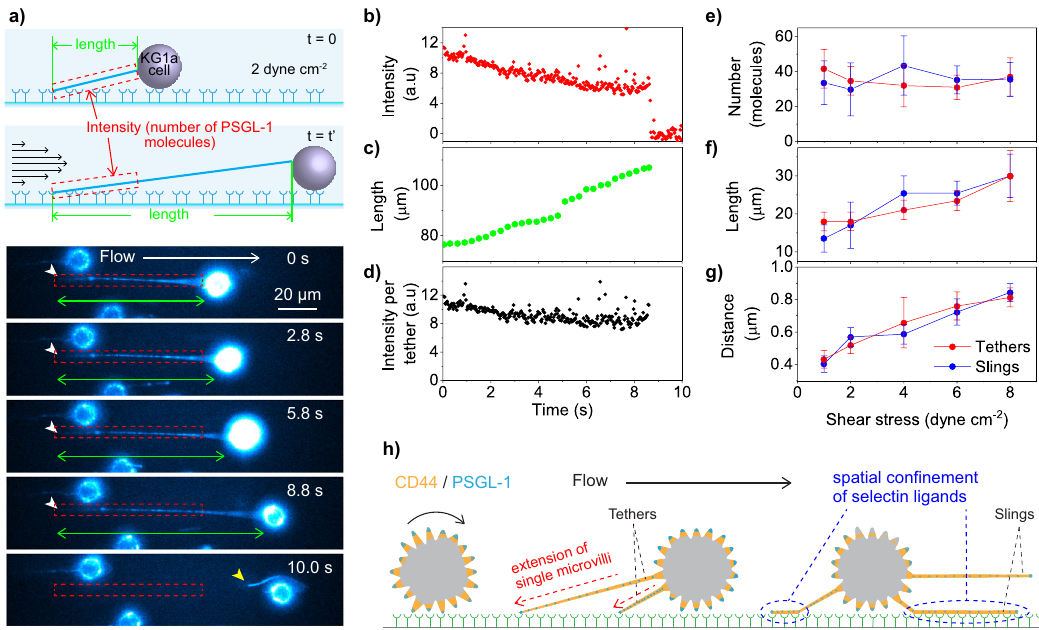
Fig. 6 Spatial con fi nement of the selectin ligands to the tethers and slings. a Time-lapse fl uorescence images of the PSGL-1 molecules (immunostained by Alexa-Fluor-555-conjugated anti-PSGL-1 antibody) on the KG1a cell captured during cell rolling over E-selectin at a shear stress of 2 dyne cm − 2 (0.2 Pa). The white arrowheads show the tethering point. The yellow arrowhead shows the tether detached from the surface E-selectin. The green arrows show the lengths of the tethers while the red dashed boxes show the areas from which the integrated intensities were calculated. The top illustration schematically shows the analysis. b Time-lapse integrated fl uorescence intensities of the PSGL-1 molecules obtained from the region designated by the red dashed boxes in ( a ). c Time-dependent change in the length of the tether obtained from the time-lapse fl uorescence images of PSGL-1 displayed in ( a ) green arrows. d Time-dependent change in the integrated fl uorescence intensity of the PSGL-1 molecules obtained from the whole tether formed during cell rolling displayed in ( a ). e Shear stress dependence of the mean numbers of the PSGL-1 molecules per tether and sling. f Shear stress dependence of the mean lengths of the tether and sling. The error bars show the standard deviations determined by 19 – 58 tethers or slings. g Shear stress dependence of the mean distances between adjacent PSGL-1 molecules on the tether and sling. The error bars show the standard deviations determined by 23 – 66 inter-spot distances. h Schematic illustration describing how the spatial con fi nement of the selectin ligands into the tethers and slings due to the formation of individual tethers from single microvilli promote stable and slow rolling of the cell on